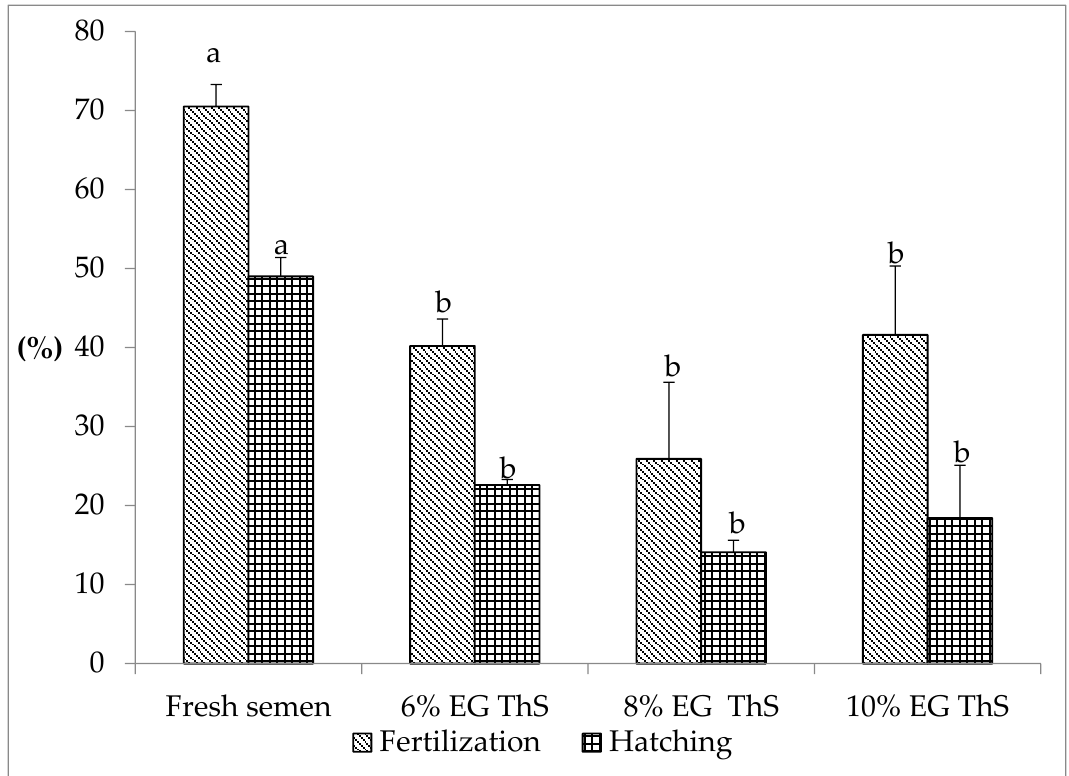
Figure 1. Fertilization and hatching rates of S. cuspicaudus using fresh or cryopreserved semen with different inclusion percentages (6, 8, and 10%) of ethylene glycol (EG). Different letters between treatments indicate differences ( p < 0.05). ThS, thawed sperm.